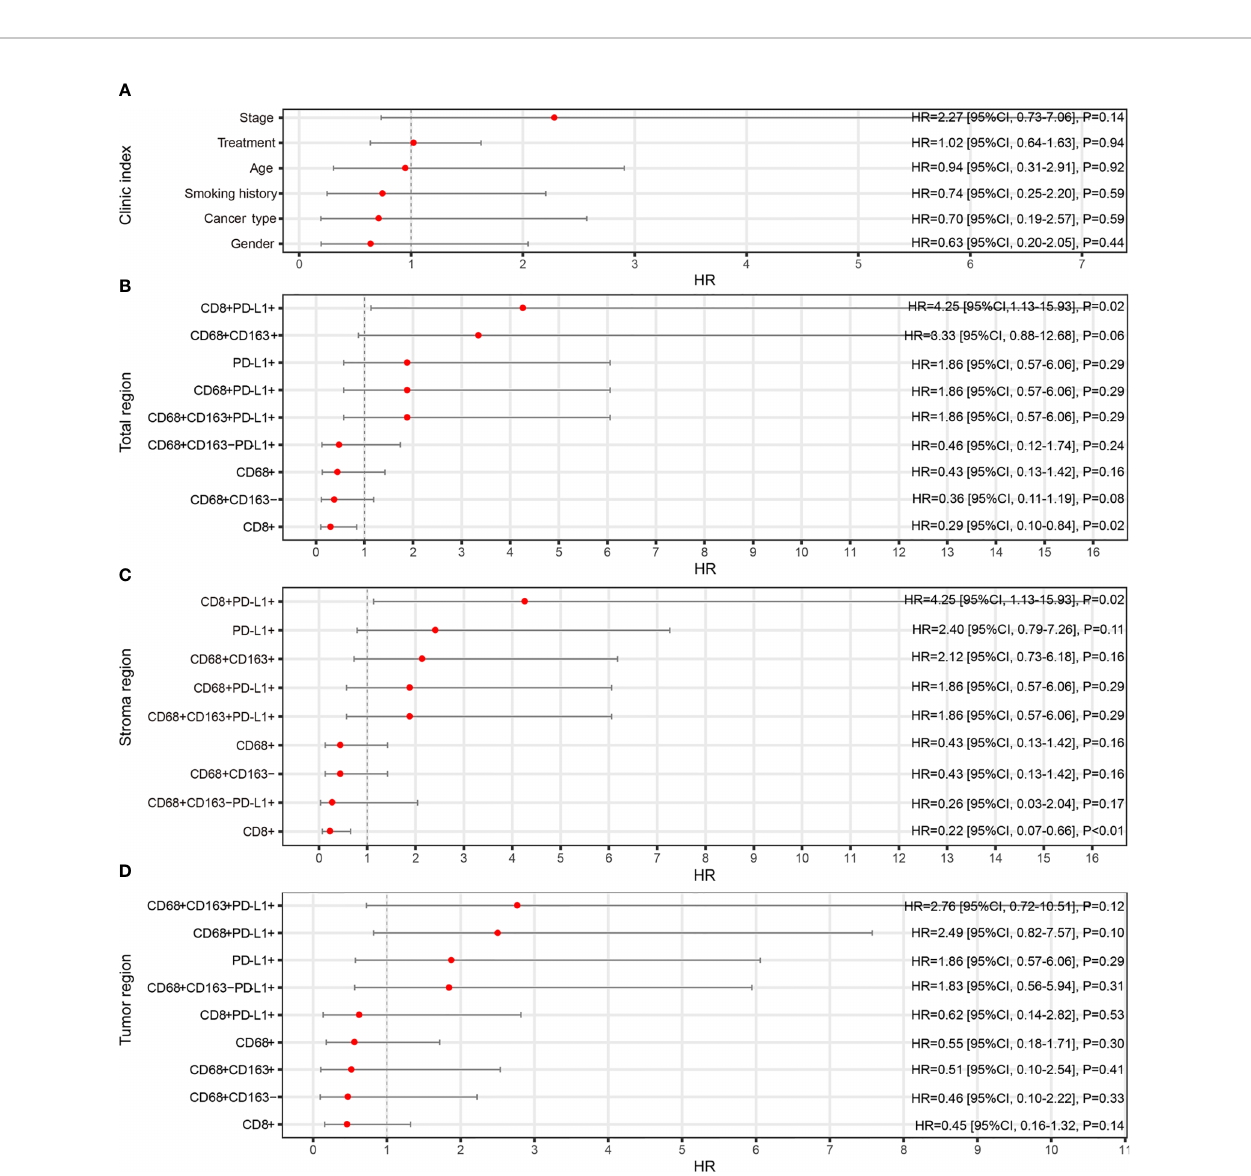
FIGURE 2 | Relationships between TAIC enrichment and progression-free survival (PFS). The forest plot of univariate survival analysis results for clinical indexes (A) and enriched TAICs in the total (B) , stromal (C) and tumor regions (D) indicates that high in fi ltration of CD8+ T cells was a protective factor for prognosis and that high in fi ltration of CD8+PD-L1+ T cells was a risk factor for